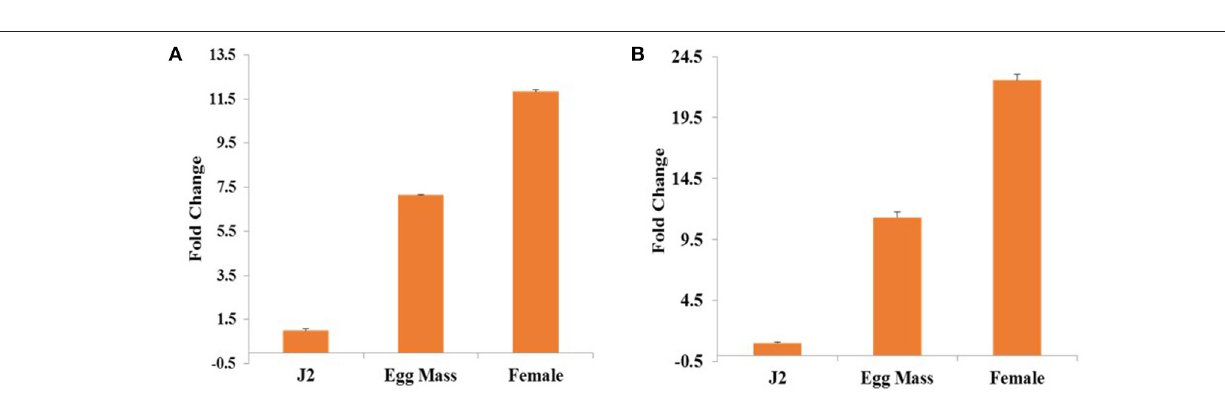
Frontiers in Plant Science |